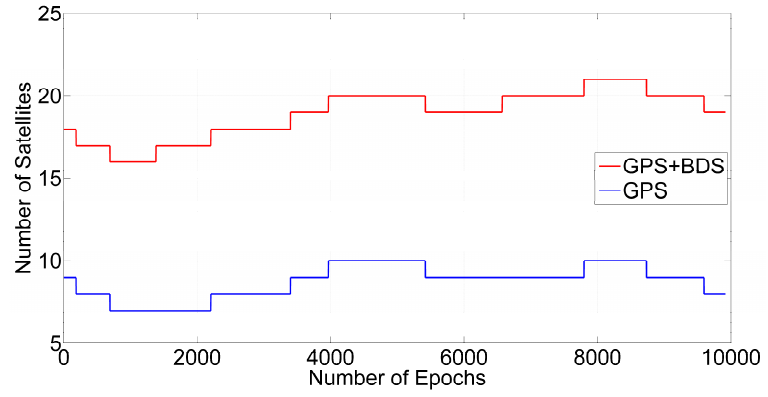
Figure 4. Satellite numbers for GPS and GPS + BDS.